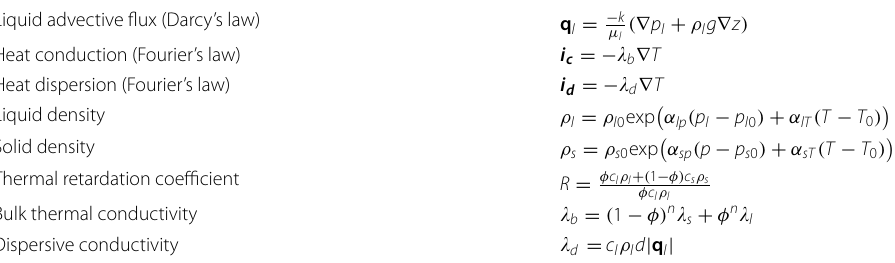
Table 1 Basic relationships for mass and momentum balance equations Liquid advective flux (Darcy’s